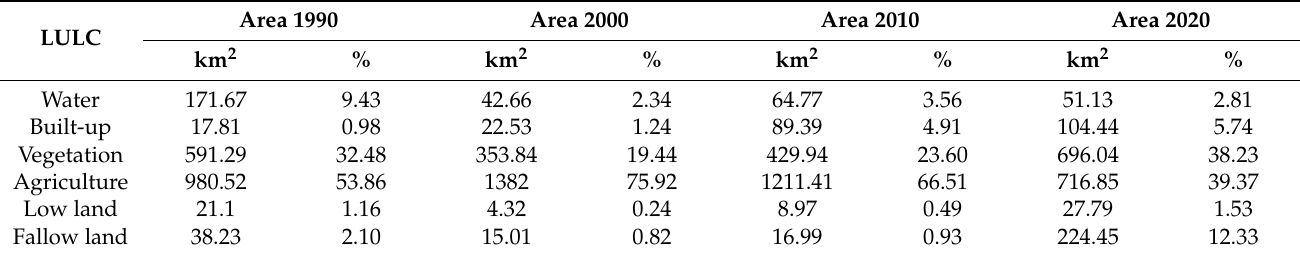
Table 4. Distribution of land use/land cover (area and percentage).